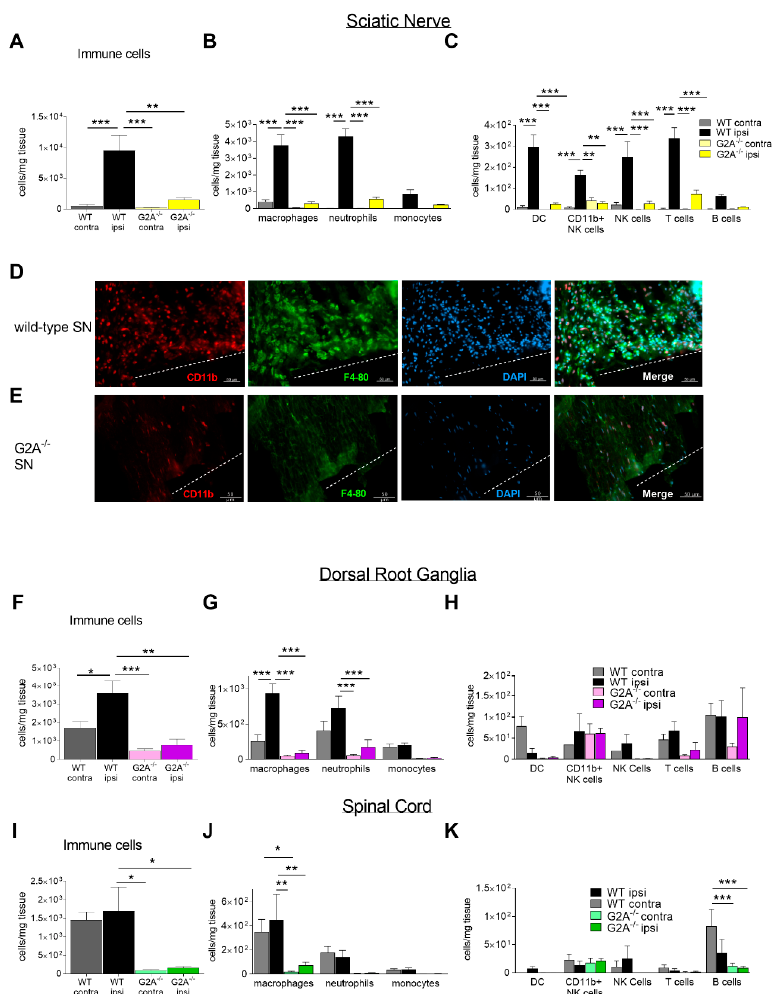
Figure 2. Reduced number of immune cells in G2A-deficient mice 7 days after SNI surgery. ( A ) Total immune cell number at the ipsi- and contra-lateral site of sciatic nerve (SN) (CD45 + ). ( B,C ) Number of different types of immune cells in the ipsi- and contra-lateral site of the sciatic nerve. ( D,E ) Immunohistochemical staining of macrophages (F4/80, CD11b) at the injured sciatic nerve (SN) in wild-type ( D ) and G2A-deficient mice ( E ) 7 days after SNI. Dashed lines indicate sites of injury. ( F ) Total immune cell number in L4-L6-DRGs at the ipsi- and contra-lateral site of sciatic nerve. ( G,H ) Number of different types of immune cells in the ipsi- and contra-lateral site of L4–L6-DRGs 7 days after SNI surgery. ( I ) Total immune cell number in the dorsal spinal cord receiving input from spinal cord comparing the ipsi- and contra-lateral site. ( J,K ) Number of different types of immune cells in the dorsal spinal cord section receiving input from L4–L6-DRGs comparing the ipsi- and contra-lateral site 7 days after SNI surgery. Data were obtained from n = 5 animals per group, male and female. Ipsilateral site of WT mice is shown in black. Ipsilateral site in SN is shown in yellow, in DRG in purple and in SC in green. Contralateral site of WT mice is depicted in dark grey. Contralateral site of G2A - / - mice is shown in light grey. Neutrophils (CD45 + , Ly6G + , CD11b + ), macrophages (CD45 + , Ly6G − , CD11b + , F4-80 + , Ly6C − ), monocytes (CD45 + , Ly6G − , CD11b + , F4-80 − , Ly6C + ), dendritic cells (DC; CD45 + , Ly6G − , CD11b + , F4-80 − , Ly6C − , CD11c + , MHCII + ), CD11b + NK cells (CD45 + , Ly6G − , CD11b + , F4-80 − , Ly6C − , NK1.1 + ), NK cells (CD45 + , Ly6G − , CD11b − , F4-80 − , Ly6C − , NK1.1 + ), T cells (CD45 + , Ly6G − , CD11b − , F4-80 − , CD3 + , MHCII − ), CD4 T cells (CD45 + , Ly6G − , CD11b − , F4-80 − , CD3 + , MHCII − , CD4 + ), CD8 T cells (CD45 + , Ly6G − , CD11b - , F4-80 − , CD3 + , MHCII − , CD8 + ), B cells (CD45 + , Ly6G − , CD11b − , F4-80 − , CD11c − , CD3 − , MHCII + , CD19 + ). Data represents mean ± SEM. * p < 0.05, ** p < 0.01, *** p < 0.005, **** p < 0.001; Two-way ANOVA with Bonferroni